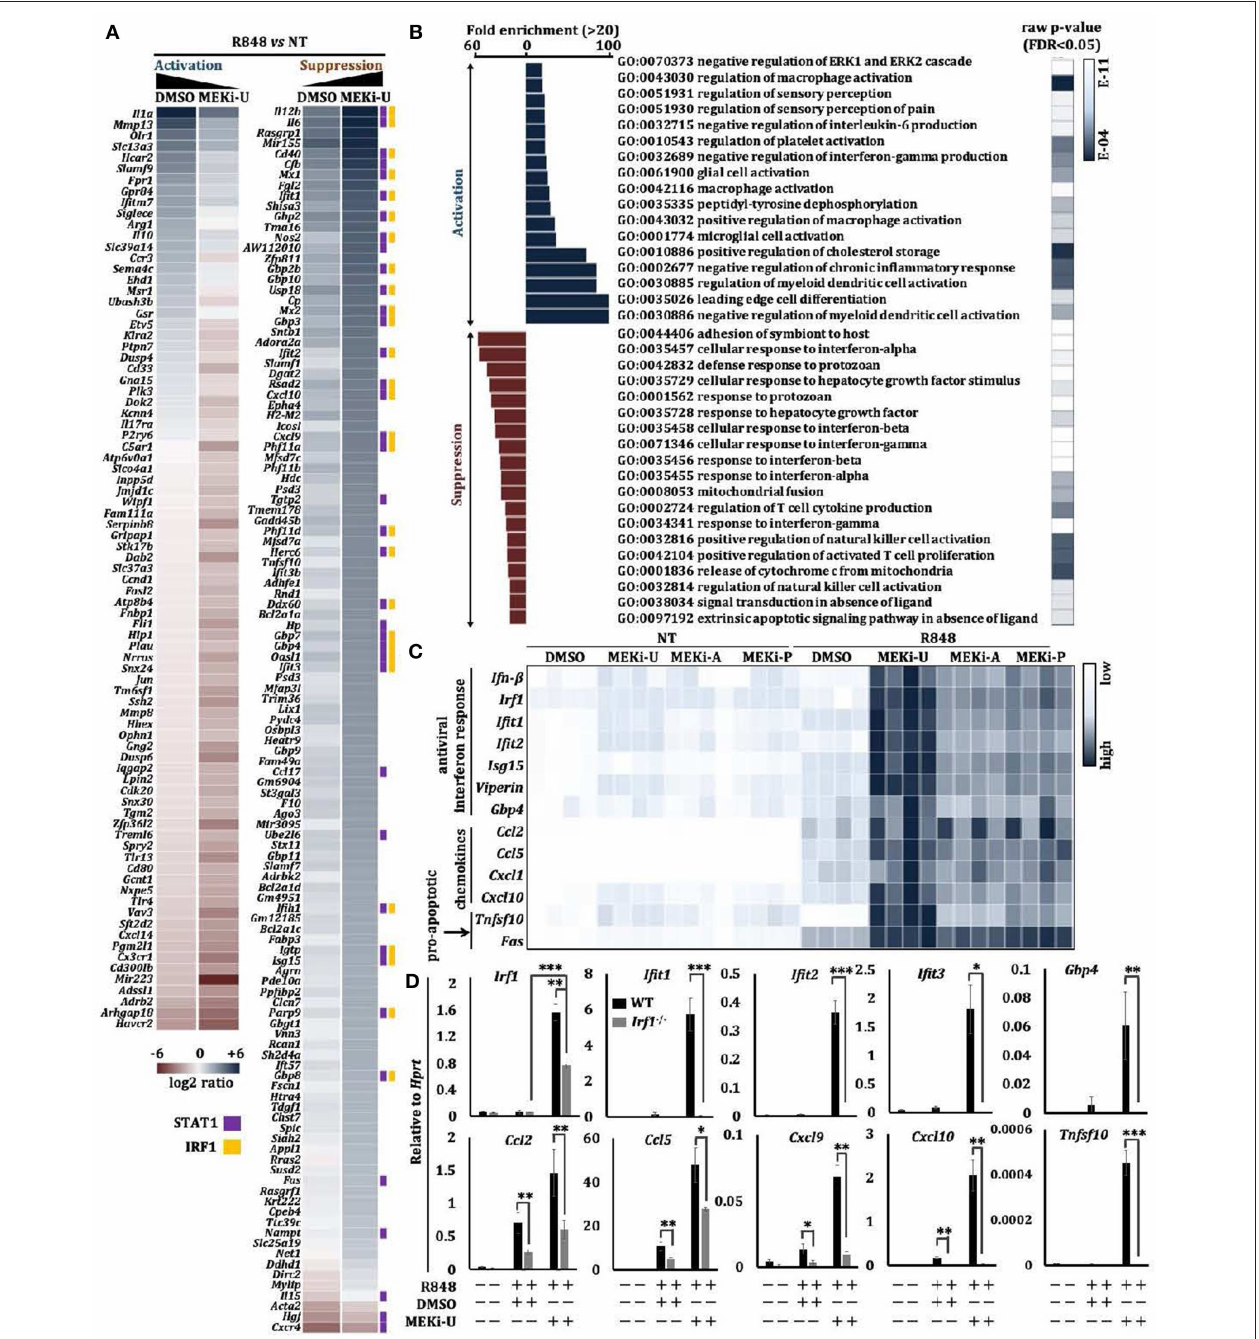
FIGURE 2 | MEK1/2 inhibitor synergizes with TLR7 agonist to unlock an interferon signature response. (A,B) Microarray analysis of BMDMs treated with TLR7 agonist R848 in the presence or absence of MEKi-U for 6h (see also Figure S2A ). Heat map (A) and Gene set enrichment analysis (B) of differentially expressed genes are from 2 independent experiments. Differentially expressed genes interacting with STAT1 and IRF1 were labeled with purple and orange squares based on STRING PPI test. (C) Heat map showing qRT-PCR analysis of the mRNA expression of selected interferon response genes, chemokines, and pro-apoptotic genes. Data are from 4 independent experiments. (D) qRT-PCR analysis of interferon response genes, chemokines, and pro-apoptotic genes in WT and Stat1 − / − BMDMs treated with TLR7 agonist R848 in the presence or absence of MEKi-U for 6h. Data are means ± SD from 4 independent experiments. * P < 0.05, ** P < 0.01, and *** P < 0.001 by unpaired Welch’s t